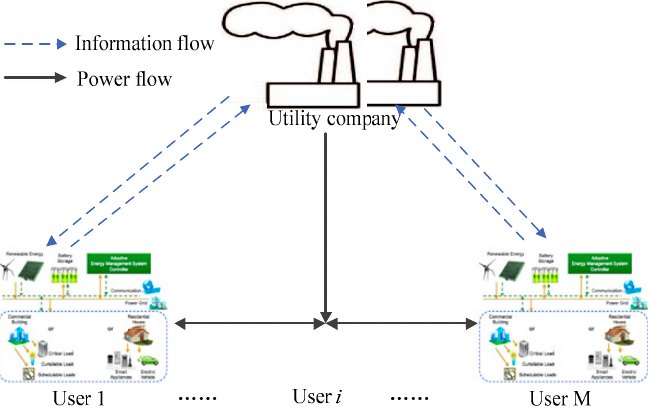
Figure 1. Power and information flows among users and the utility.